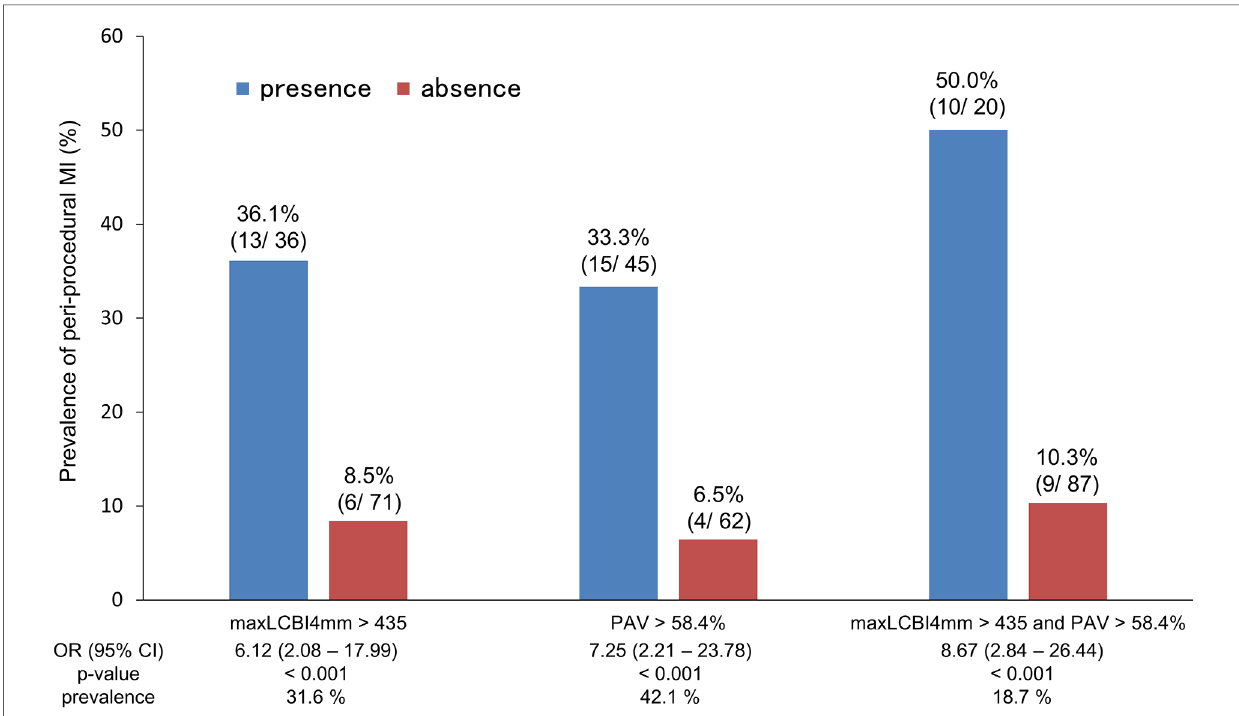
FIGURE 5 Frequency of periprocedural myocardial injury according to PAV and maxLCBI4mm. PAV, percent atheroma volume; maxLCBI4mm, maximum value of the lipid-core burden index for any 4-mm segment; OR, odds ratio; CI, con fi dence